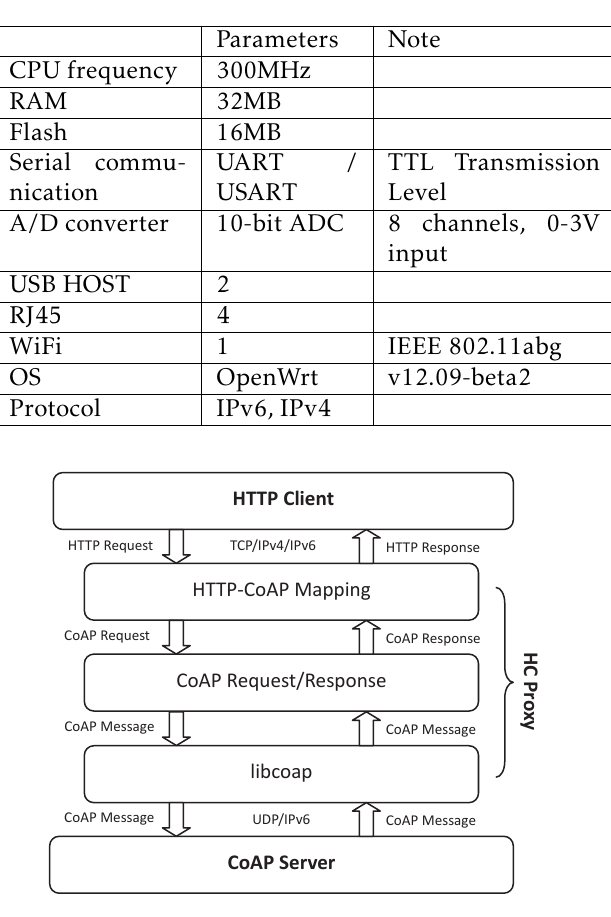
Figure 7. Interaction process of HC